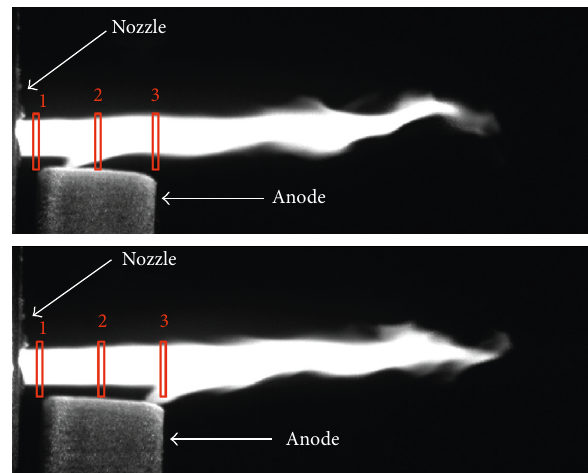
Figure 2: Example of the temporal evolution of the cathode-anode voltage. Figure 3: High-speed camera images of the plasma arc and jet for two cases: minimum voltage (a) and maximum voltage (b). Images come from a high-speed movie with 20,000fps; exposure time is 1 μ s. Red rectangles show positions of the entrance slit for spec- troscopic